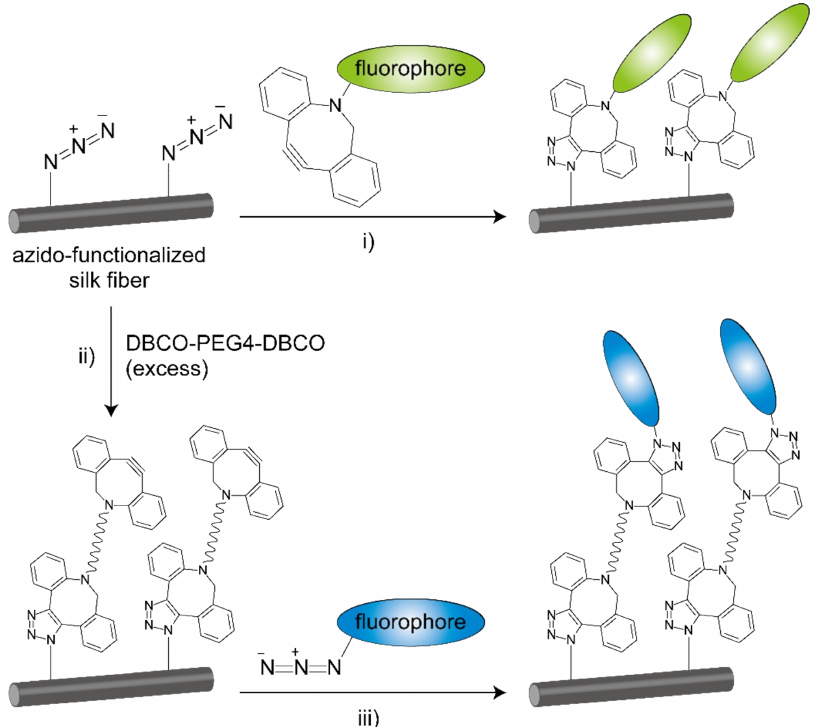
Figure 3. Modification of the azido-functionalized silk fiber with fluorophores by SPAAC. (i) SPAAC between azido groups in silk fibroin and DBCO groups in fluorescent reagents to form stable triazole rings. (ii) Azido groups in silk fibroin can be converted into DBCO groups by the reaction with excess DBCO-PEG4-DBCO. (iii) SPAAC between DBCO groups in silk fibroin and azido groups in fluorescent